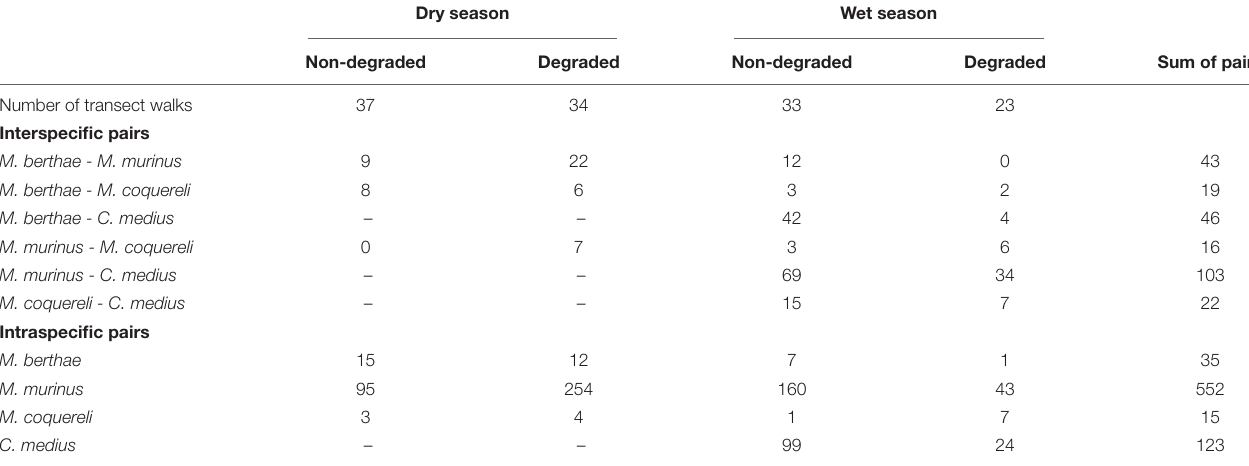
three of these values were statistically significant. The pooled data showed significant evidence of segregation at both scales. At the local scale, there was segregation during the dry season in non-degraded habitat supporting Hypothesis 1b, but no evidence of segregation in the degraded habitats and thus no support for Hypothesis 1c. Hypothesis 2a predicted segregation between M. murinus and M. coquereli , which was observed at the regional scale in the pooled data ( Figure 2A ) and in all scenarios but in degraded habitat during the dry season ( Table 4B and Supplementary Figure 2A ). In contrast, no segregation was observed between M. berthae and M. coquereli ( Table 4B and Figure 2B ), complying with Hypothesis 2b. On the regional scale, those two species were even positively associated in degraded habitat during the dry season ( Supplementary Figure 2B ). Negative spatial association of M. murinus and M. coquereli within transects was limited to the dry season with food scarcity ( Supplementary Figure 2A ) and thus conforms with Hypothesis 2c. Segregation patterns found between M. murinus and Figure 3A ). Lack of avoidance between M. berthae and C. medius on the regional scale ( Table 4C and Figure 3B ) and attraction within transects in non-degraded habitats ( Supplementary Figure 3B ) supported Hypothesis 3b. Segregation of M. murinus and C. medius was detected at the regional level in non-degraded habitat ( Supplementary Figure 3A ) and within transects in degraded habitat, which indicates both competition for tree holes and food according to Hypothesis 3c.